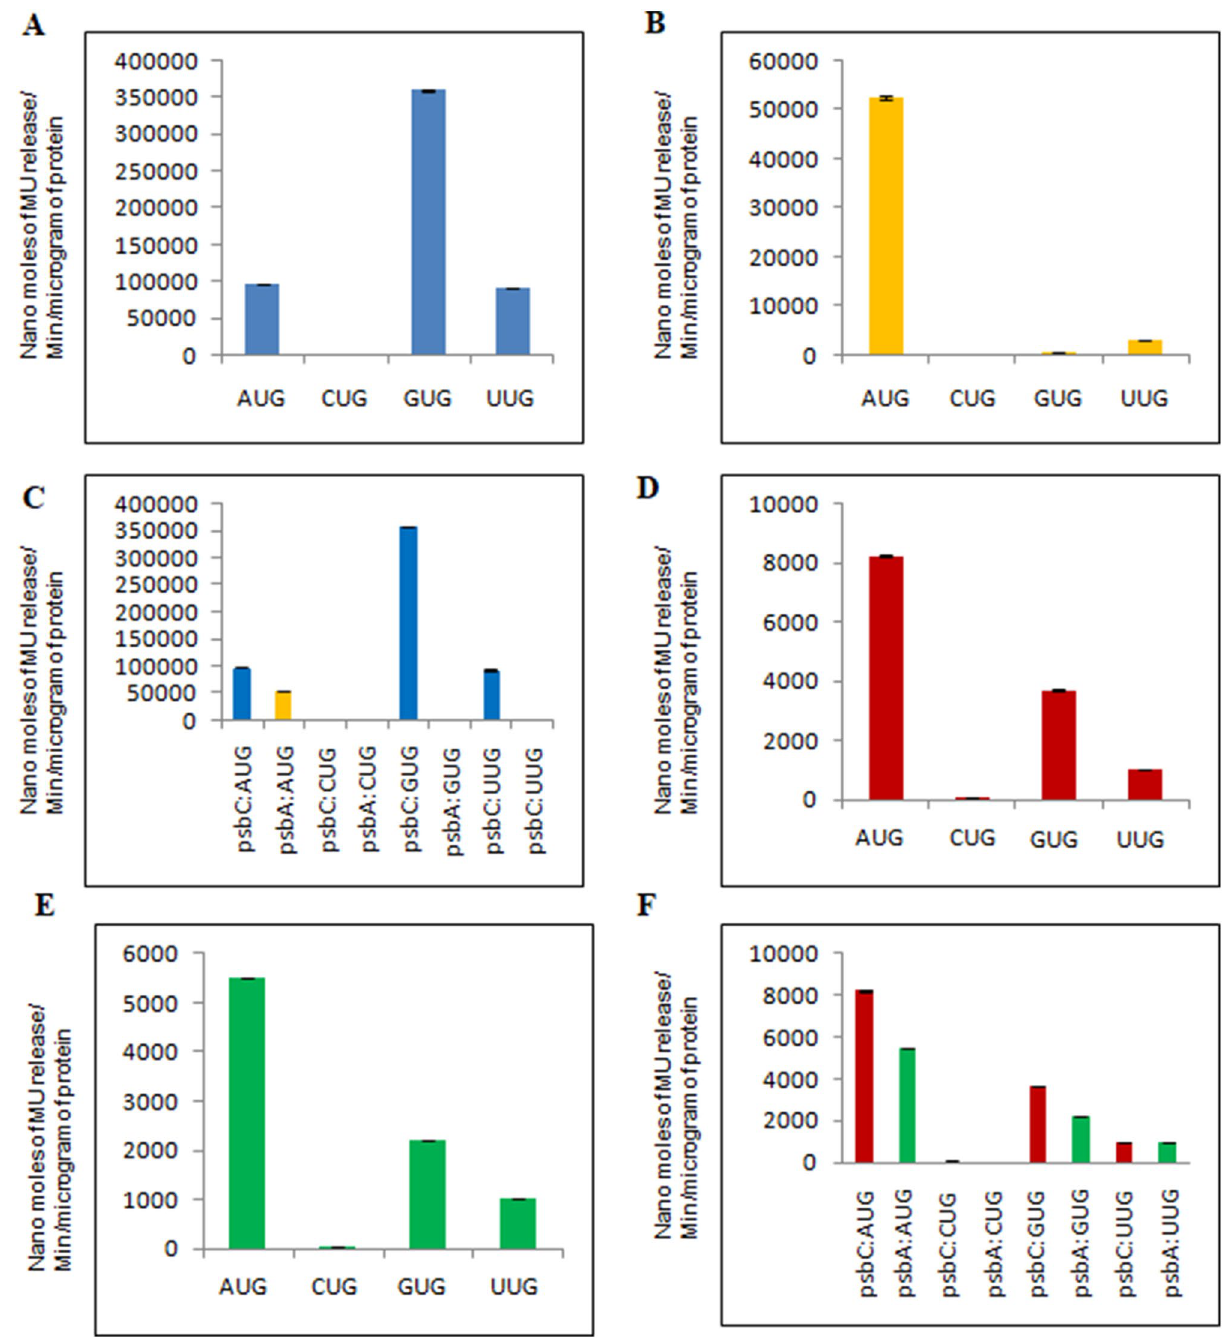
Figure 5. Comparison of GUS expression levels in transplastomic tobacco plants under different translation initiation codons (AUG, CUG, GUG, and UUG), driven by either tobacco psbC or rice psbA promoter and comparison of same constructs expressed in E. coli . Expression of GUS in tobacco chloroplasts under the regulation of native tobacco psbC promoter ( A ) and heterologous rice psbA promoter ( B ). Expression of GUS in E. coli under tobacco psbC promoter ( D ) and rice psbA promoter ( E ). Comparison of GUS expression under psbA and psbC promoters in N. tabaccum ( C ) and E. coli ( F